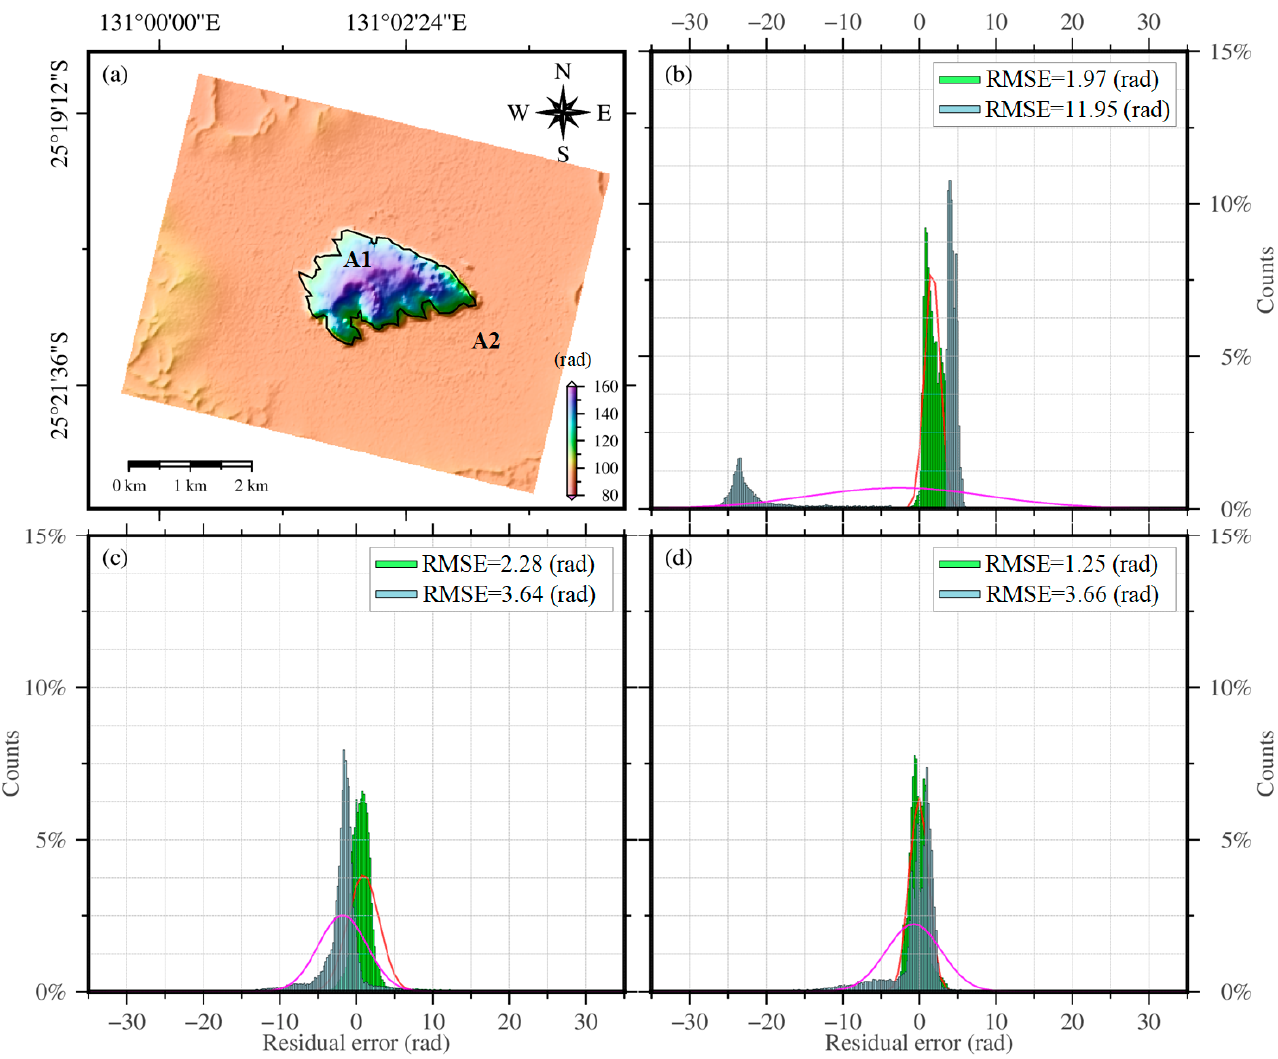
Figure 5. Comparison of residual statistical results of the conventional InSAR ( b ), RSSI ( c ), and RID ( d ) methods. The light blue bar represents the residual distribution of A1 area in ( a ). The green bar represents the residual distribution of A2 area in ( a ). The red and purple curves represent the fitted probability distribution functions of the residual for A1 and A2, respectively.